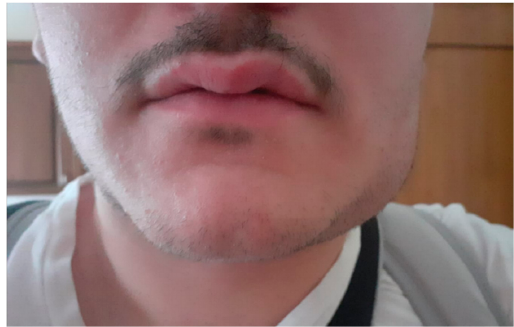
Figure 5. First visit to patient with odontogenic abscess left mandibular angle.